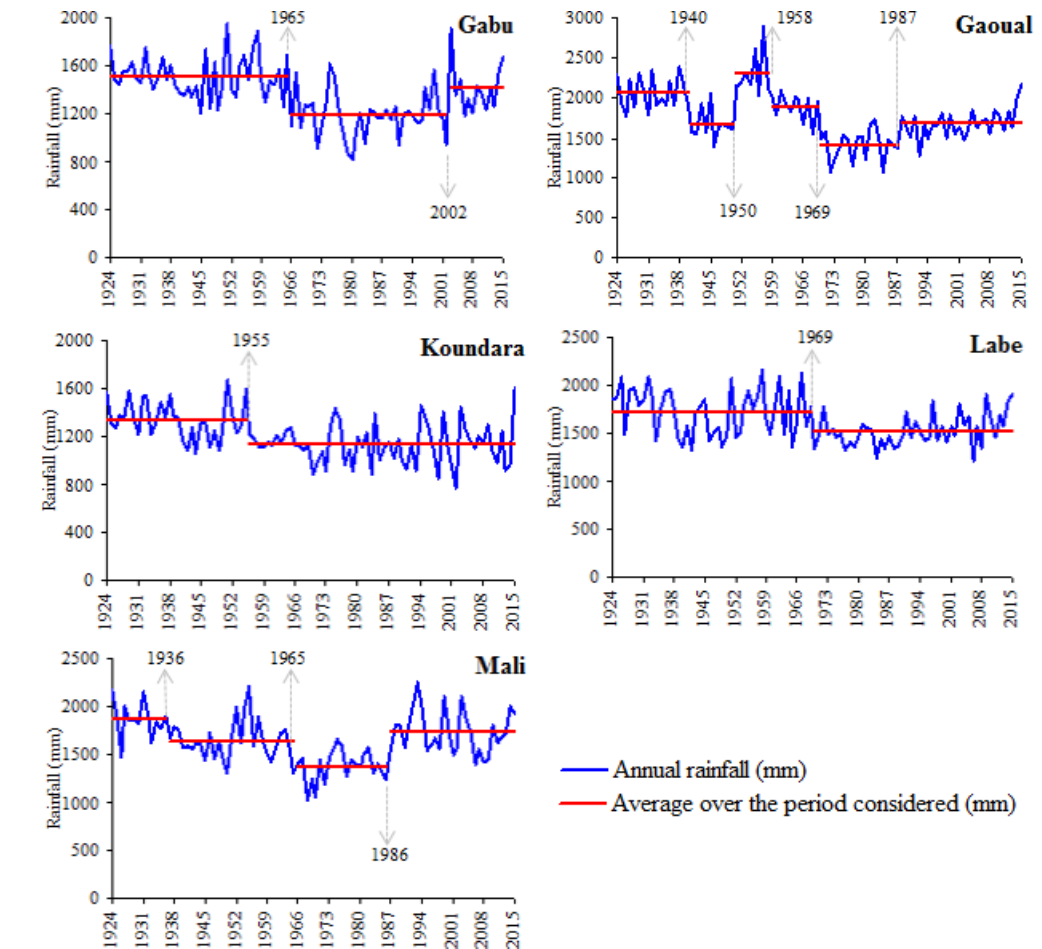
Figure 7. Variability and segmentation of annual rainfall in Gabu, Gaoual, Koundara, Labe and Mali from 1924 to 2015.